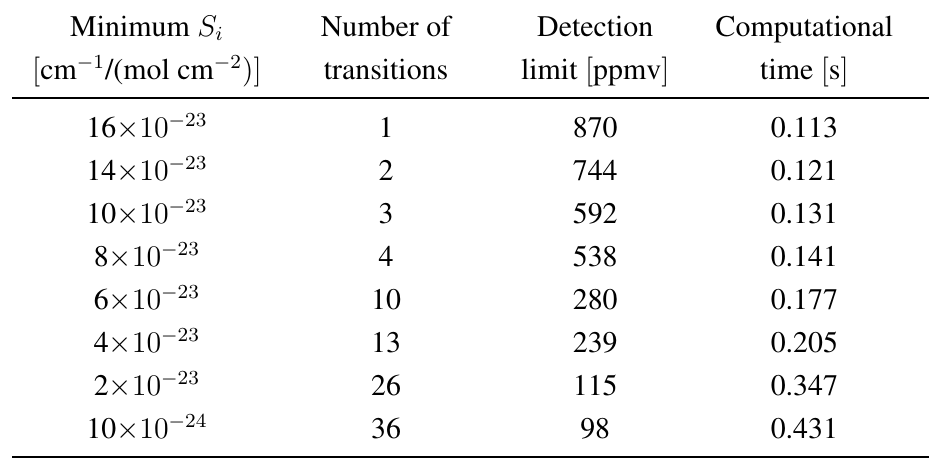
Table 1. Detection limit and computational time required according to the number of transi- tions